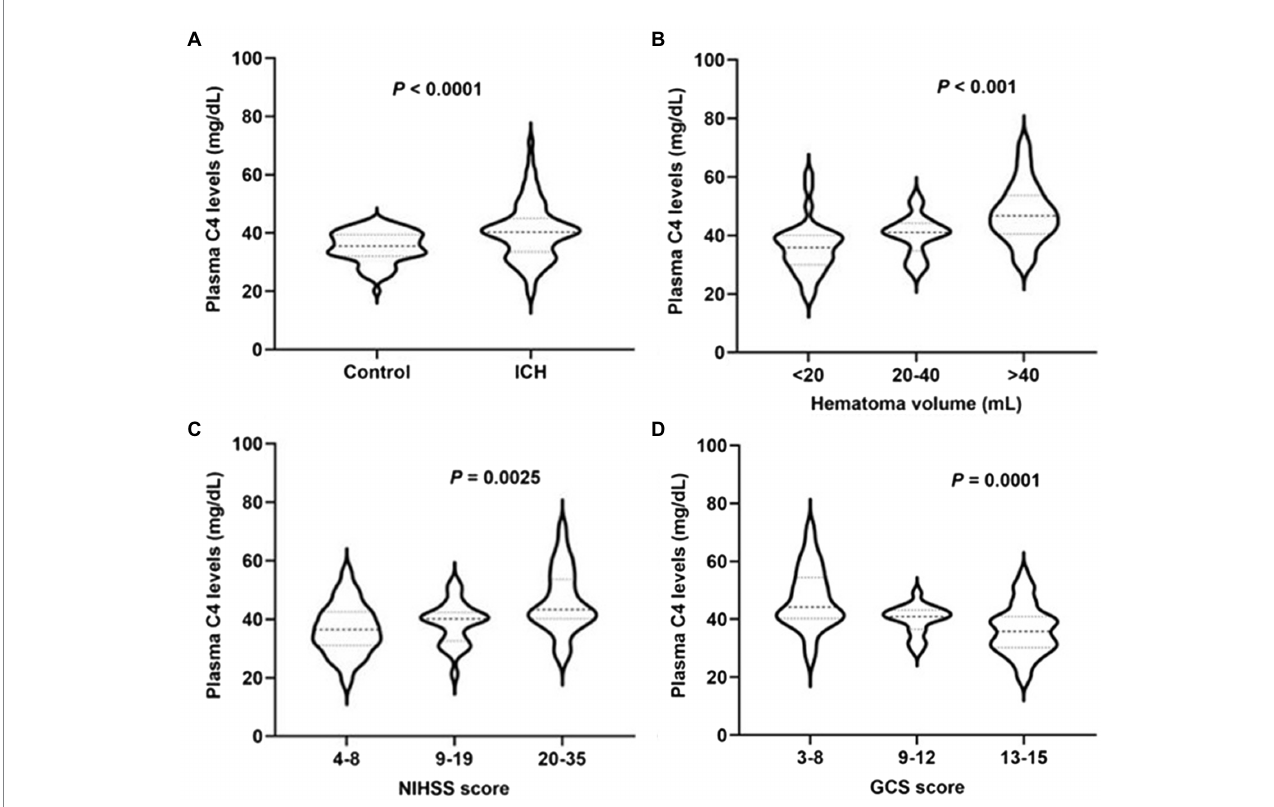
FIGURE 2 High plasma complement C4 levels in ICH patients and are associated with hemorrhagic severity. Plasma C4 levels were reported as median (upper-lower quartiles). (A) Plasma complement C4 level in ICH and healthy controls. Association of plasma C4 levels to (B) hematoma volume, (C) NIHSS score, and (D) GCS score after acute ICH patients. ICH, intracerebral hemorrhage; NIHSS, National Institutes of Health Stroke Scale; GSC, Glasgow Coma